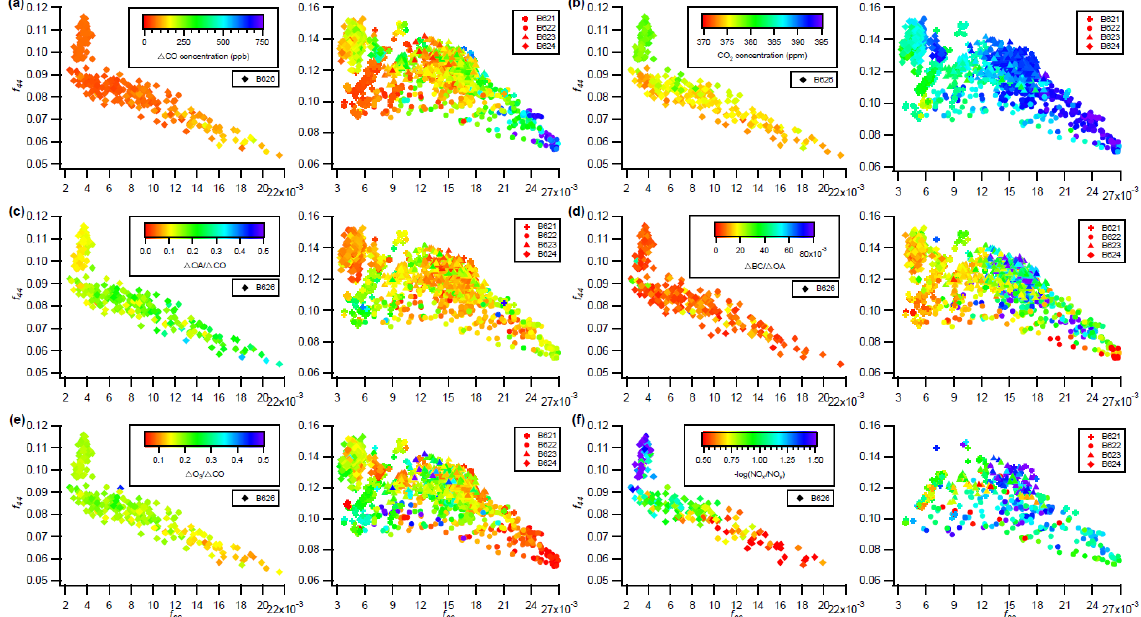
Figure 8. f 44 vs. f 60 with data points coloured by (a) (cid:49) CO, (b) CO 2 , (c) (cid:49) OA /(cid:49) CO, (d) (cid:49) BC /(cid:49) OA, (e) (cid:49) O 3 /(cid:49) CO and (f) − log(NO x / NO y ). Data from fresh and aged plumes are shown on the left and right hand side of each panel, respectively.